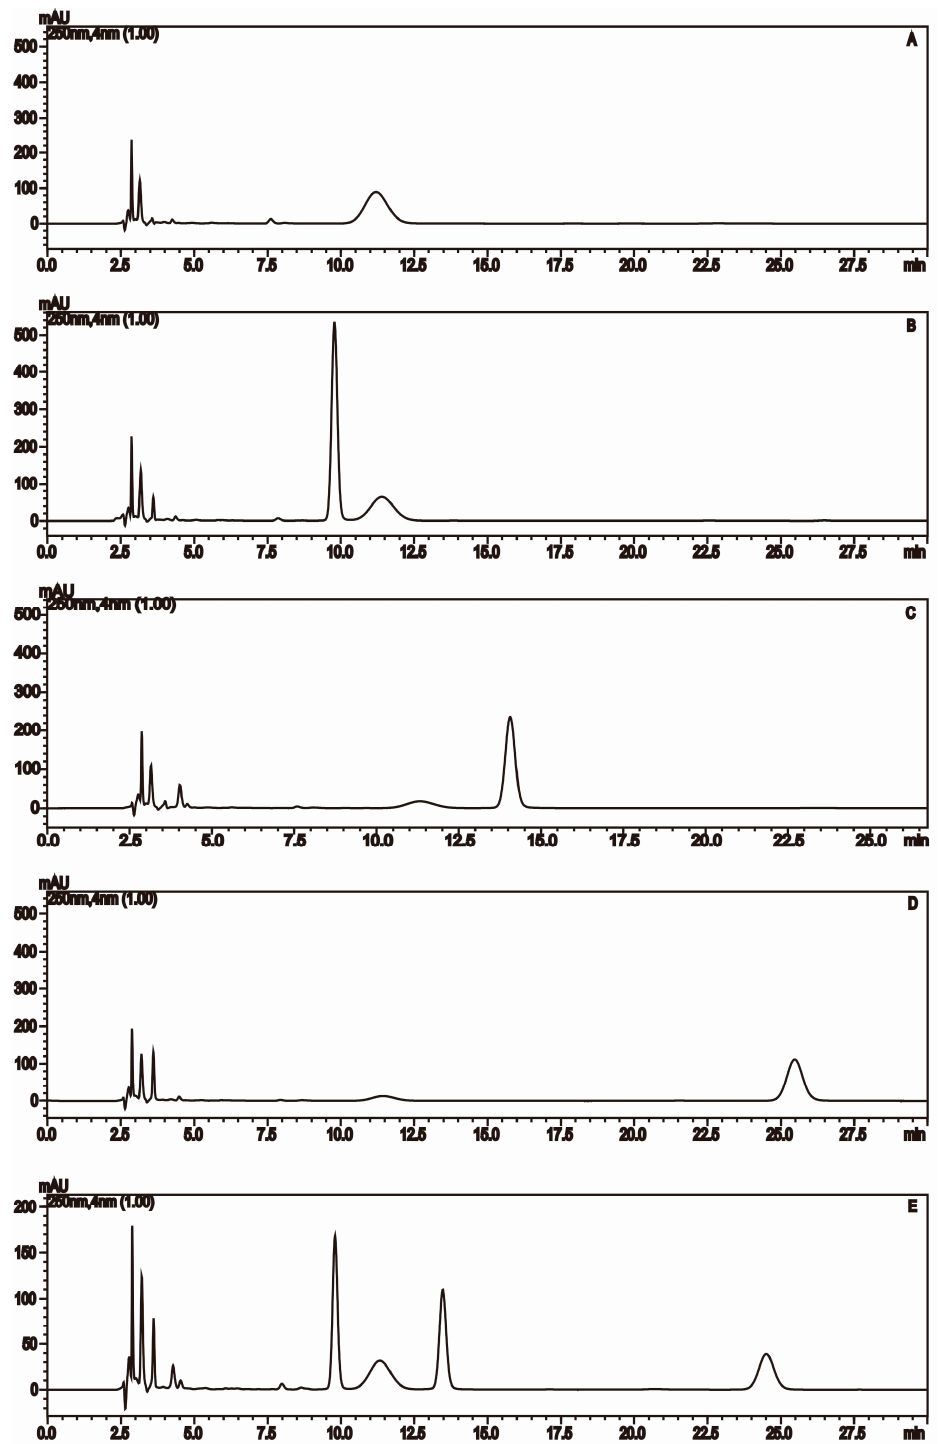
Figure 1. Chromatogram of three double PMP-labeled monosaccharides: ( A ) Blank control; ( B ) PMP-labeled mannose; ( C ) PMP-labeled rhamnose; ( D ) PMP-labeled glucose; and ( E ) three mixed PMP-labeled monosaccharides.